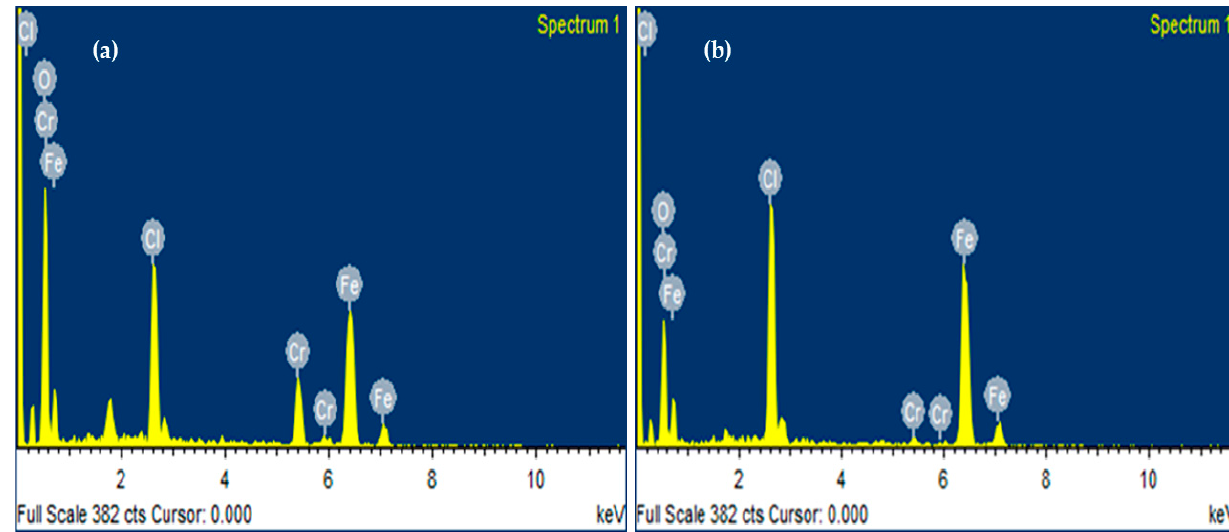
Figure 5. ( a,b ) . EDX spectrum of biofabricated algal- and plant-based Fe 3 O 4 NPs, showing sharp peaks for iron and oxygen. It also depicts other elements, such as chlorine and chromium, but with low mass percentages.